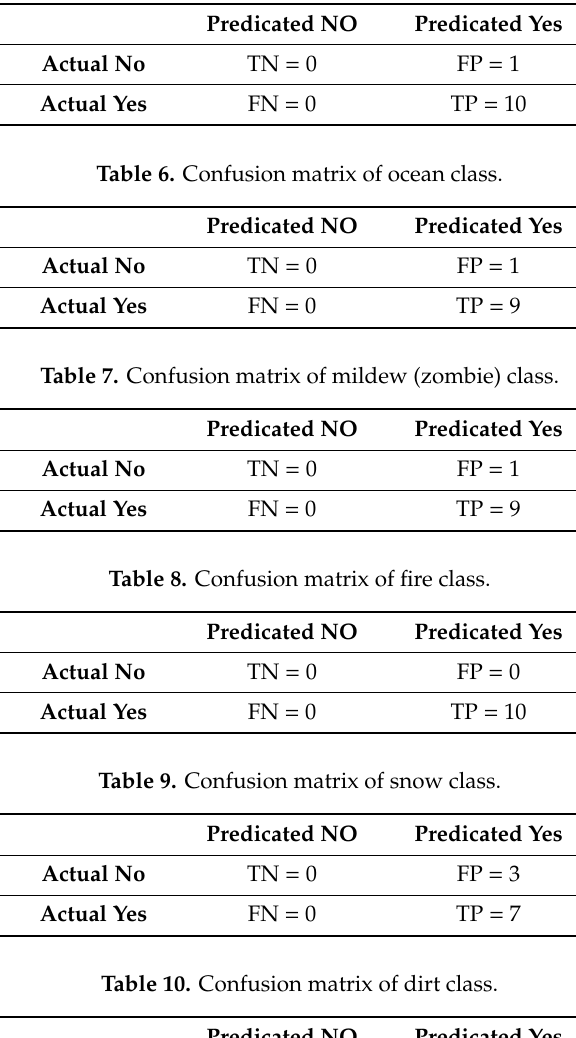
Table 5. Confusion matrix of grass class.